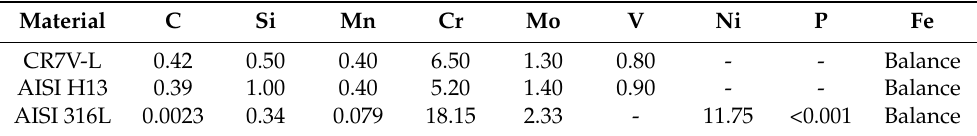
Table 1. Chemical composition (wt. %) of the used materials, data from [19–22].